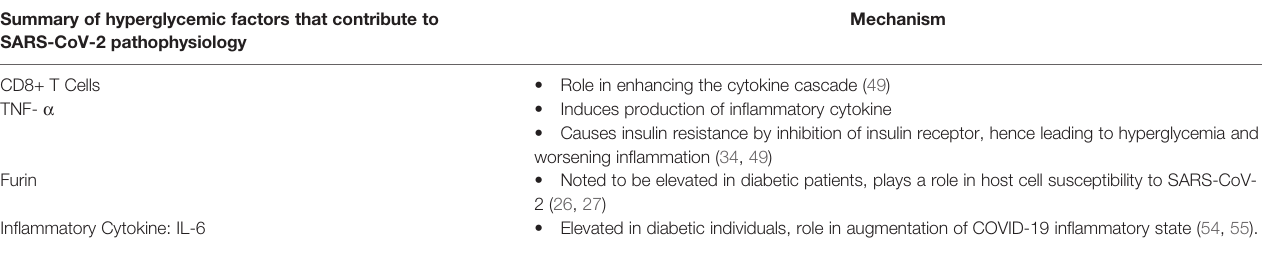
TABLE 2 | Summary of the main factors of diabetes that contribute to SARS-CoV-2 pathophysiology as discussed in this paper. Summary of hyperglycemic factors that contribute to SARS-CoV-2 pathophysiology